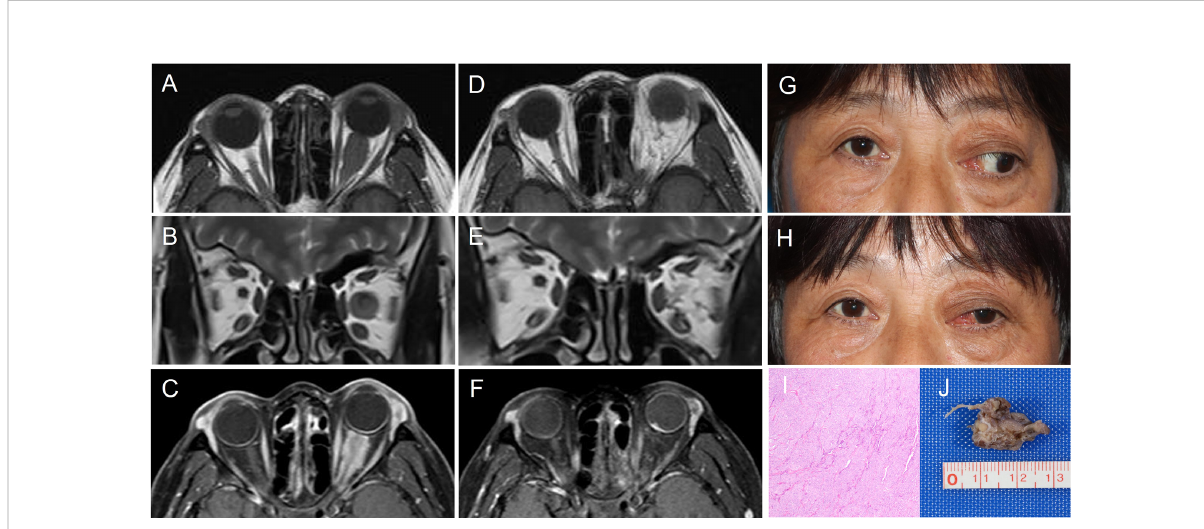
FIGURE 2 Representative case: a 43-year-old female with longstanding visual loss and proptosis of the left eye. Preoperative MRI, (A) T1-weighted axial MRI, (B) T2-weighted coronal MRI, (C) T1-contrast-enhanced axial MRI. The patient number and corresponding details for this patient (Patient 2) are shown in Table 1. Postoperative MRI demonstrating complete tumor removal, (D) T1-weighted axial MRI, (E) T2-weighted coronal MRI, (F) T1- contrast-enhanced axial MRI. (G, H) Pre- and postoperative appearance at the one month follow up. Resected tumor pathological fi ndings (I) indicated that the tumor was an optic nerve sheath meningioma. The formalin- fi xed resected tumor sample (J)